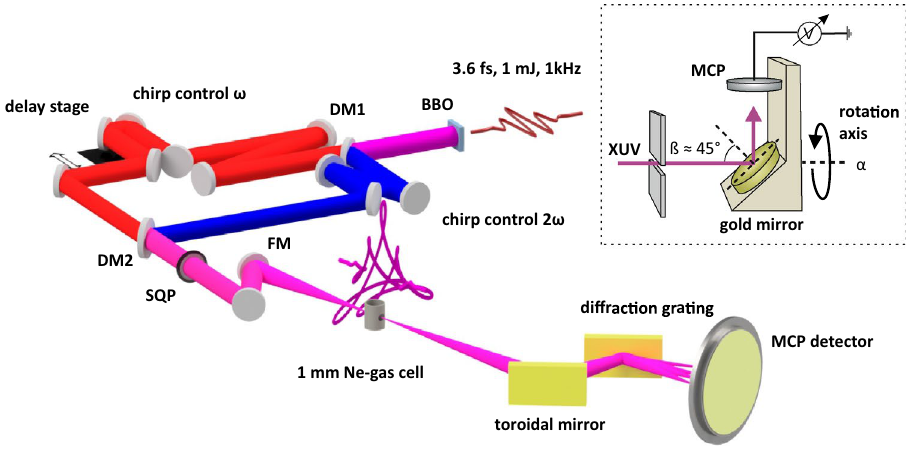
Figure 1. Experimental setup for the generation of circularly polarized harmonics in TCBC approach. The elements: BBO- beta-barium borate crystal; DM1, DM2- dichroic mirrors; SQP- superachromatic quater-wave- plate; FM- focusing mirror f = 350 mm; MCP- detector for XUV radiation. The analyer which replaces the MCP-detector for polarization measurements is shown in the insert, where β is the incidence angle and α is the rotation (azimuthal) angle of the analyzer.